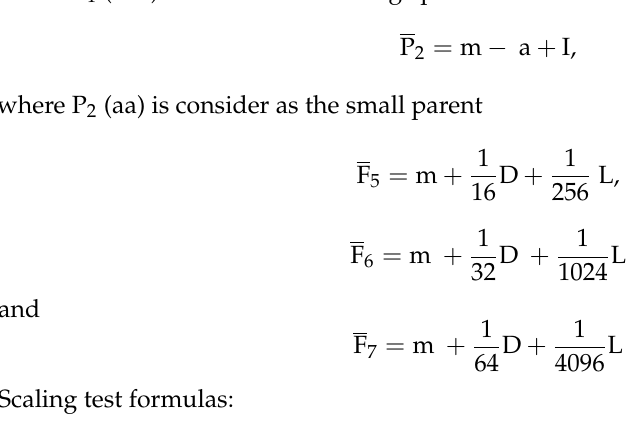
Table 1. Coefficients of the parameters used in the genetic model for generation means analysis. Gene Actions Additive-Dominance Model Non-Allelic (Epistasis) Populations m a D I = aa L = DD P 1 1 +1 0 +1 0 P 2 1 − 1 0 +1 0 F 5 0 +1/16 0 +1/256 F 6 1 0 +1/32 0 +1/1024 F 7 1 0 +1/64 0